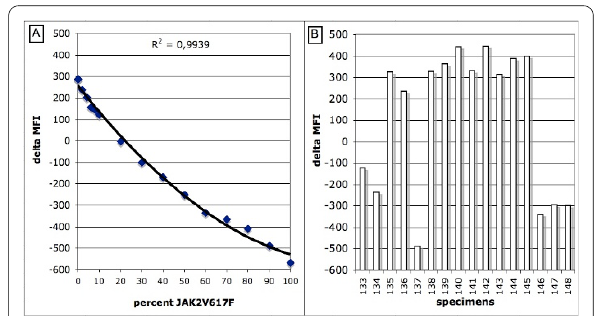
Figure 5 Polynomial graphic representation of the standard curve (A) and quantitative detection of JAK2V617F from speci- mens (B) . Typical representation of the delta MFI curves and bar graphs applied to the detection of JAK2V617F variant from specimens. The percentage of mutated alleles is determined by comparing the height of the bar graphs from specimens with the standard curve. The equation is Y = 0.0473X 2